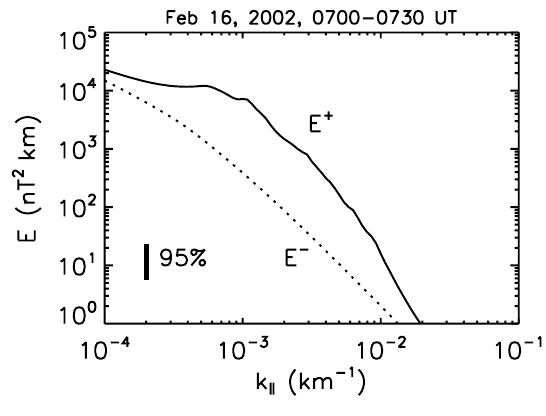
Fig. 1. Example of anisotropic energy spectrum as a function of the wave number parallel to the mean magnetic field, taken from the Cluster observation in the shock-upstream region after Narita et al. (2007). The solid curve represents the spectrum for magnetic field fluctuations in the direction away from the bow shock ( E + ) and the dotted curve represents that in the direction toward the bow shock ( E −